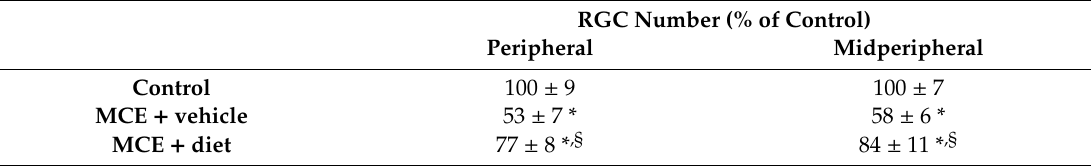
Table 1. E ff ect of dietary supplementation on RGC number in peripheral and midperipheral retina. RGC Number (% of Control) Peripheral Midperipheral Control 100 ± 9 100 ± 7 MCE + vehicle 53 ± 7 * 58 ± 6 * MCE + diet 77 ± 8 * ,§ 84 ± 11 * ,§ Data are shown as mean ± SEM ( n = 5 for each group). * p < 0.001 versus control; § p < 0.001 versus MCE mice fed with vehicle (one-way ANOVA followed by the Newman–Keuls multiple comparison post-hoc test). The RGC number in the peripheral and midperipheral retina was 9170 ± 825 and 12240 ± 857, respectively, in agreement with previous findings